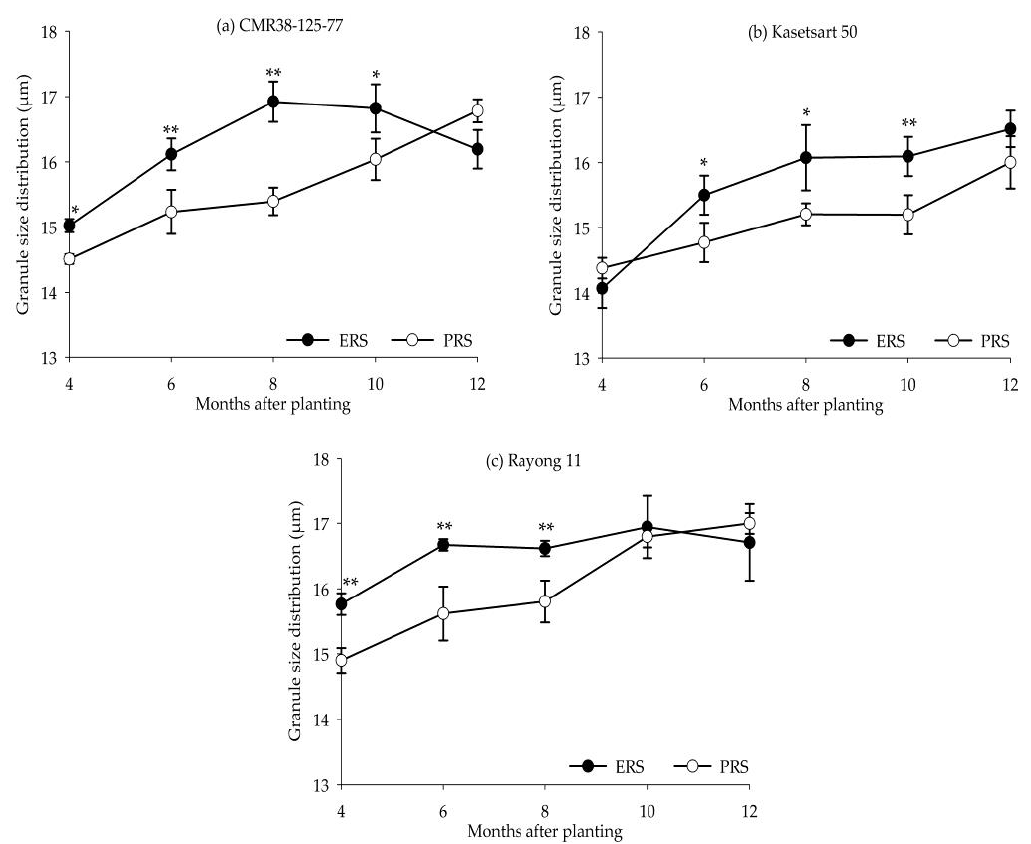
Figure 3. Means of starch granule size of three cassava genotypes in the early rainy seasons ( ERS ) and post rainy seasons ( PRS ). *, ** = significant differences between baseline and the respective time point at p < 0.05 and significant at p < 0.01 level, respectively (LSD test). All data are presented as mean ± standard error of the mean ( n = 8). ( a ) = CMR38-125-77, ( b ) = Kasetsart 50 and ( c ) = Rayong 11.